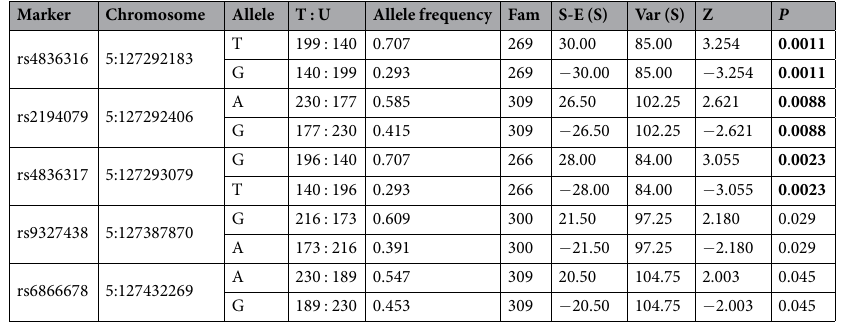
Table 1. Association analyses of 5 SNPs in MEGF10 in 410 trios using FBAT in an additive model. Abbreviations: T, transmitted; U, untransmitted; Fam, number of informative families; S, test statistics for the observed number of transmitted alleles; E(S), expected value of S under the null hypothesis (i.e., no linkage and no association). Note: T : U is the ratio of transmissions to non transmissions of the allele; P value in bold font indicates persistent statistical significance after Bonferroni correction.